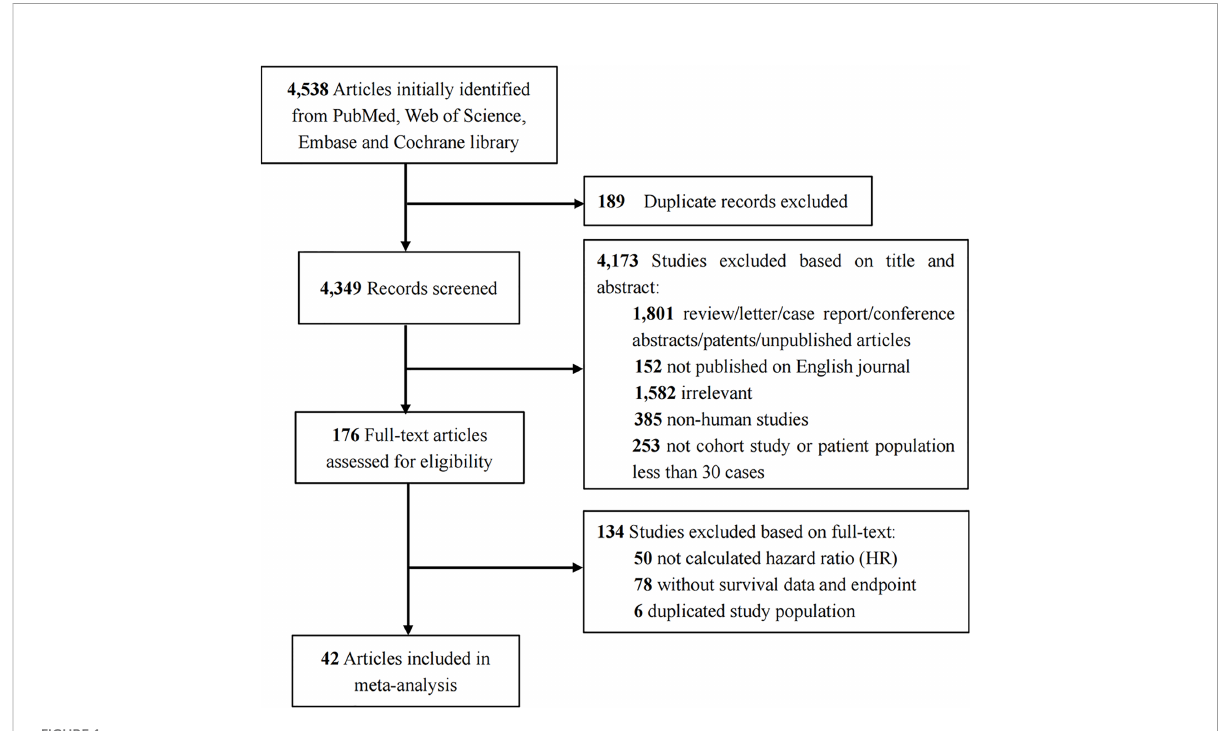
FIGURE 1 Flow diagram for selection of